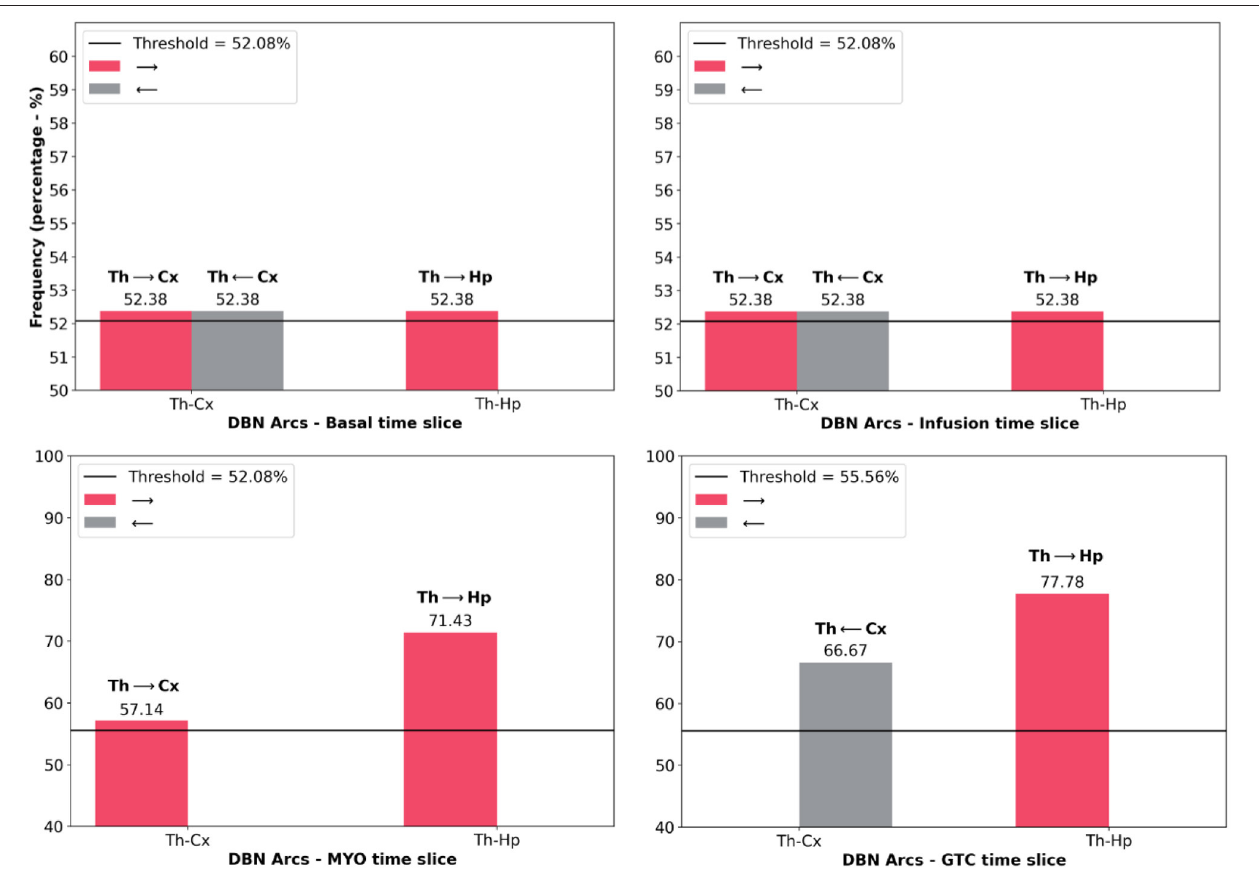
FIGURE 6 | Histograms of the frequency of main arcs from DBN presented in Figure 5 . They were separated according to each time slice: Basal, Infusion, MYO and GTCS. Table 1 shows only the arcs that were above the threshold value (black line in histogram) provided by the analytical threshold model. In this Figure, it is also possible to observe that an opposite connection is unchecked at times, such as TH-CX during MYO time slice (TH did not). The exception is during Basal and Infusion time slices in which it is possible to observe the same frequency for TH-CX arcs.